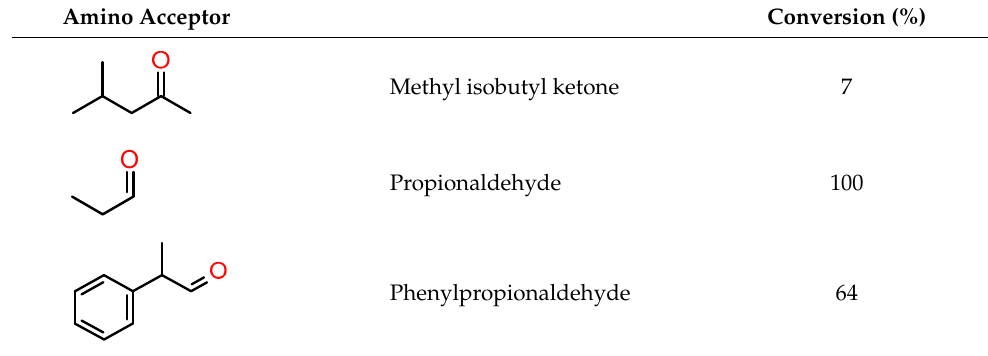
Table 3. Amino acceptor spectrum of Sbv333-TA. Amino acceptor